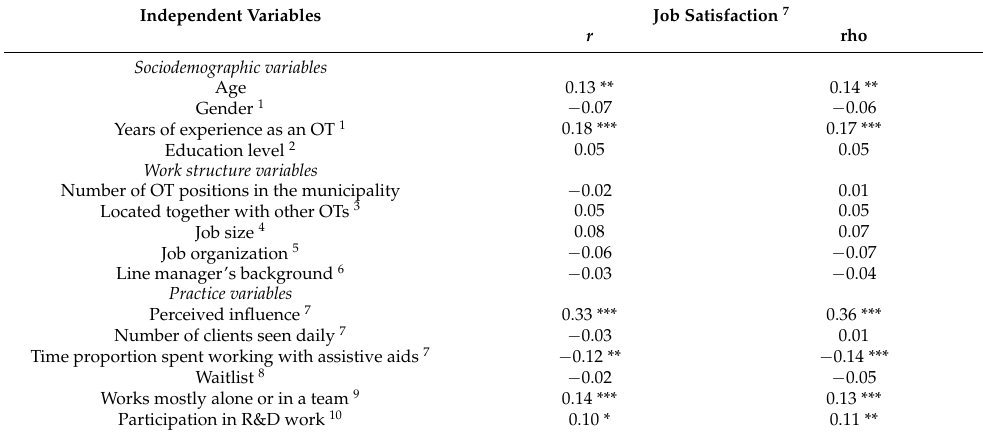
Table 2. Unadjusted associations between independent variables and job satisfaction (JSS ratings).